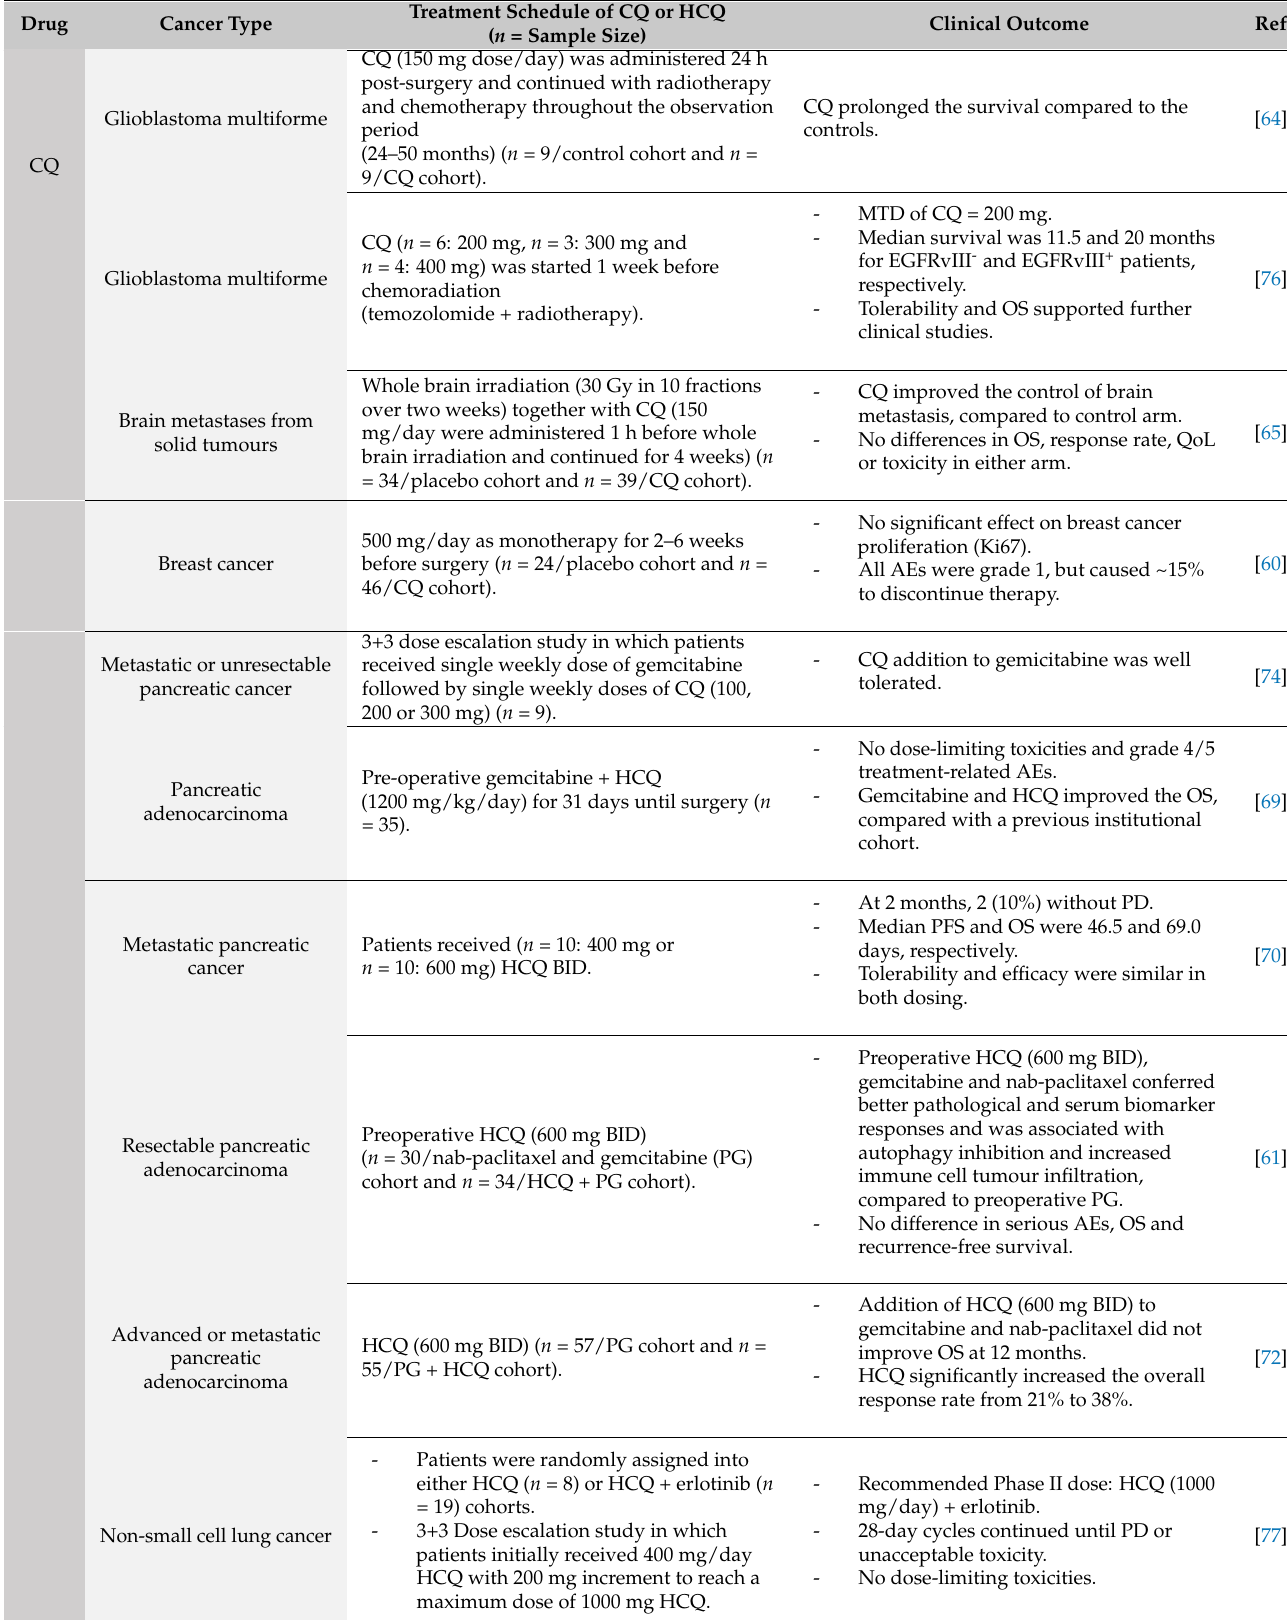
Table 1. Clinical trials of chloroquine (CQ) and hydroxychloroquine (HCQ) in cancer